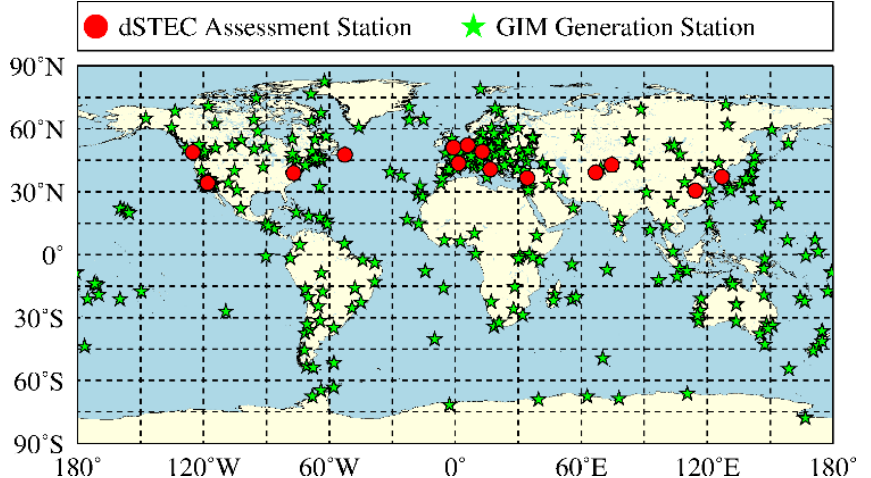
Figure 4. Distribution of ground-based GNSS station used for assessment.